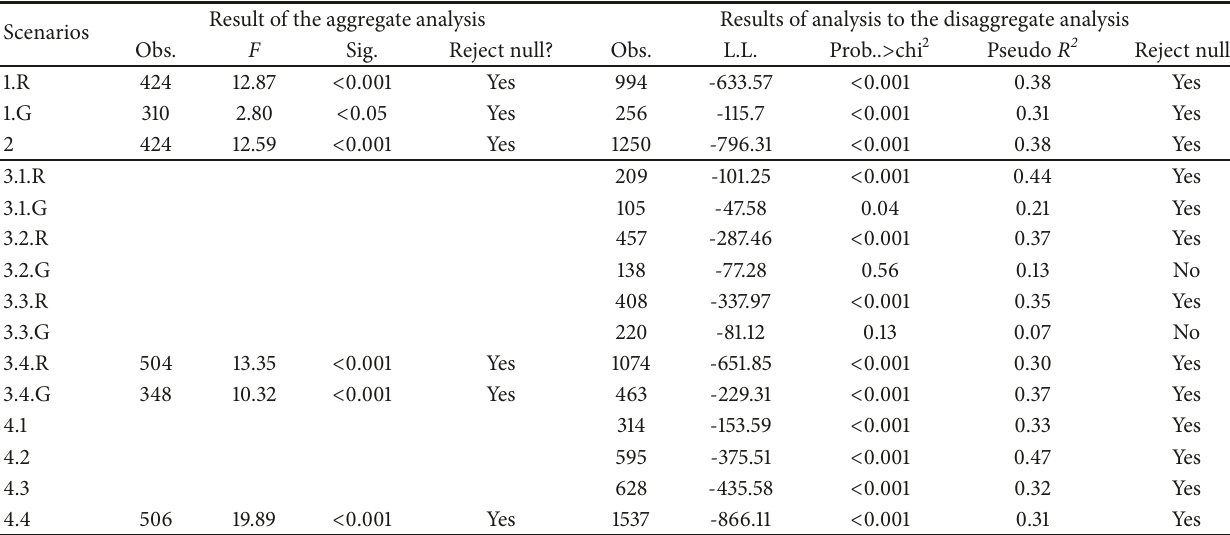
Table 6: Testing